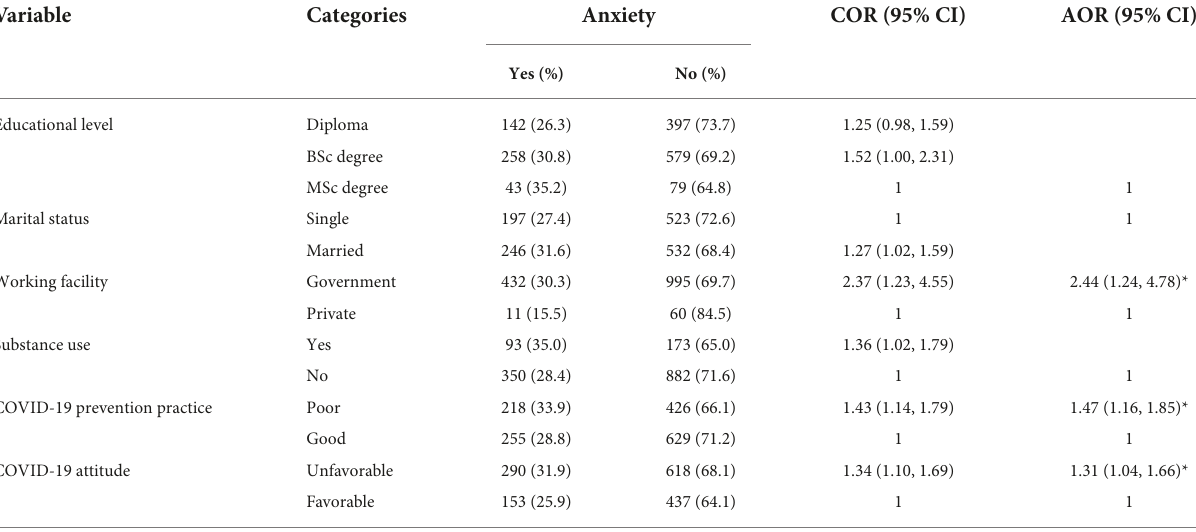
TABLE 3 Bivariable and multivariable logistic regression analysis for factors associated with anxiety among midwives in Ethiopia in 2020 ( n = 1,498).